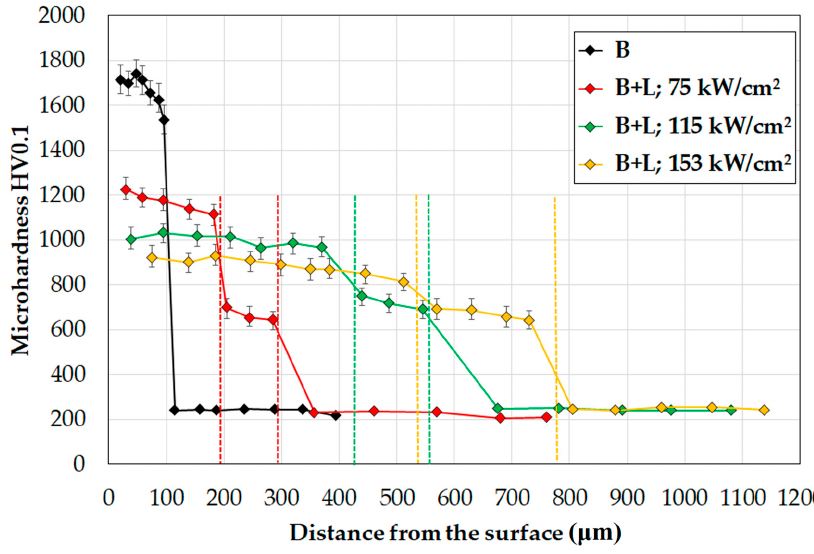
Figure 5. Microhardness profiles of the diffusion boronized layer.